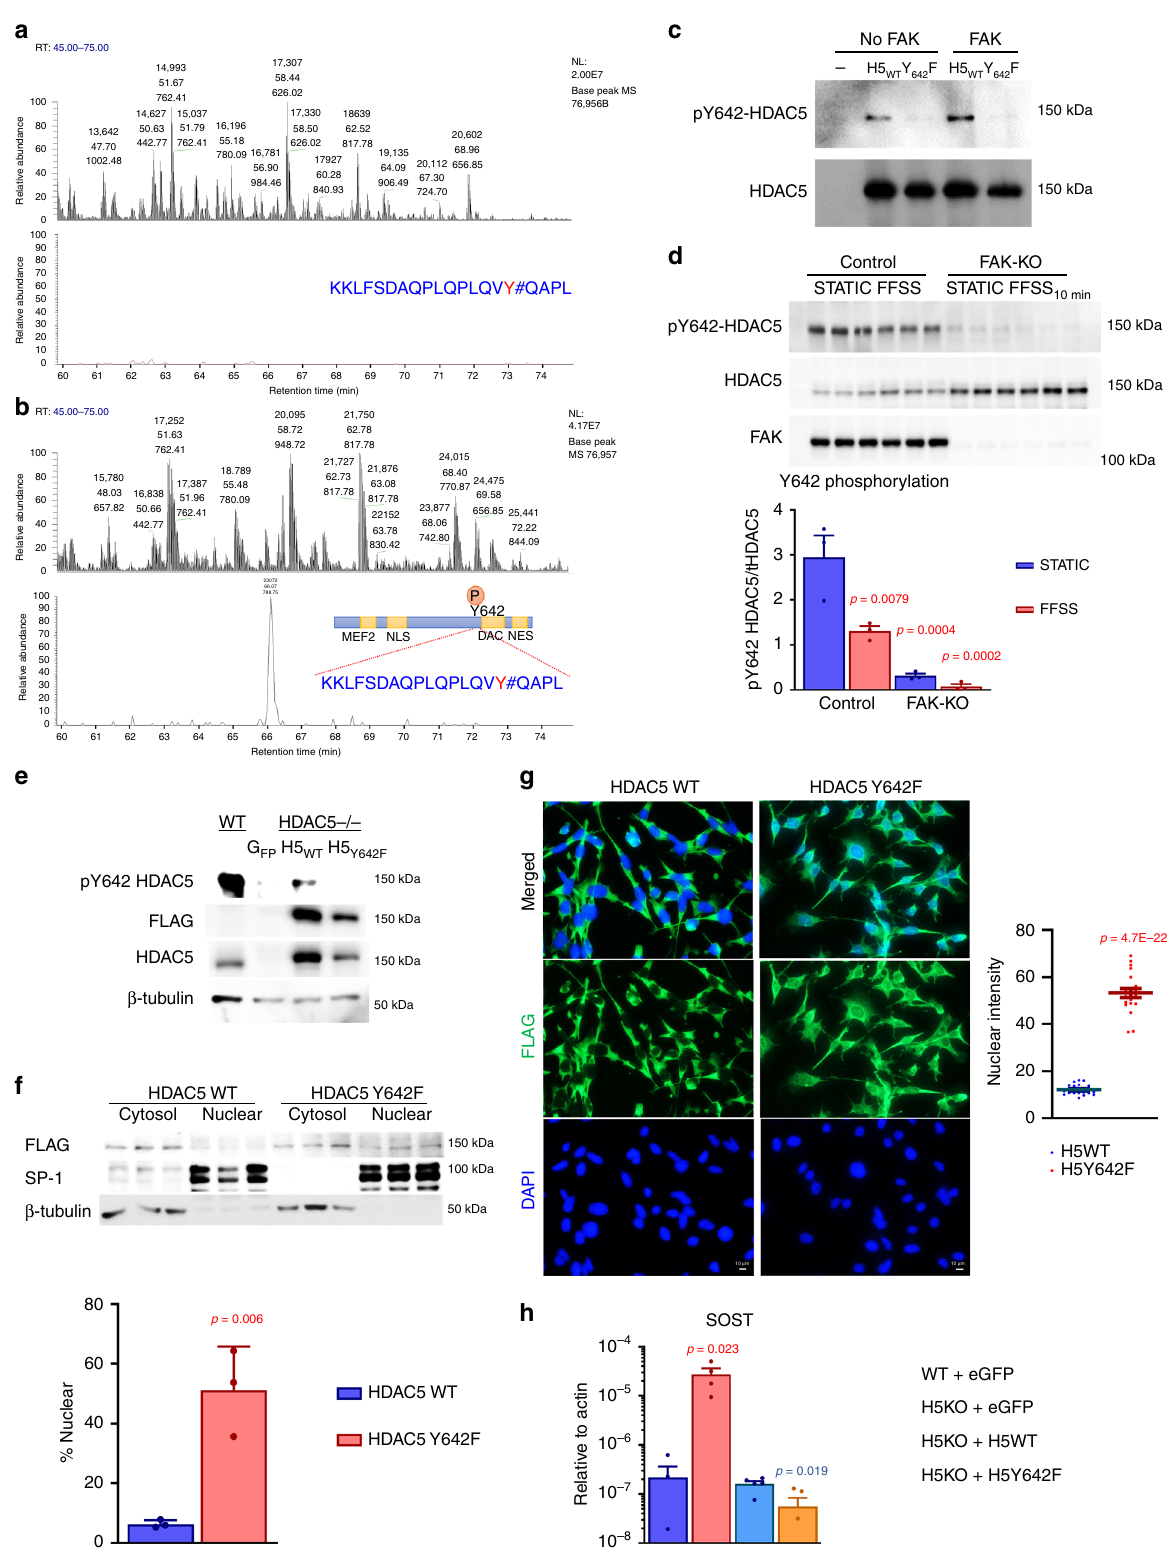
(Fig. 7e), similar to what we observed with mechanical loading (Fig. 1d), FFSS (Fig. 2a), and FAK inhibitors (Fig. 4c). Ocy454 cells express multiple integrin isoforms predicted to bind collagen-rich ECM (Supplementary Fig. 8A, B). Deletion of